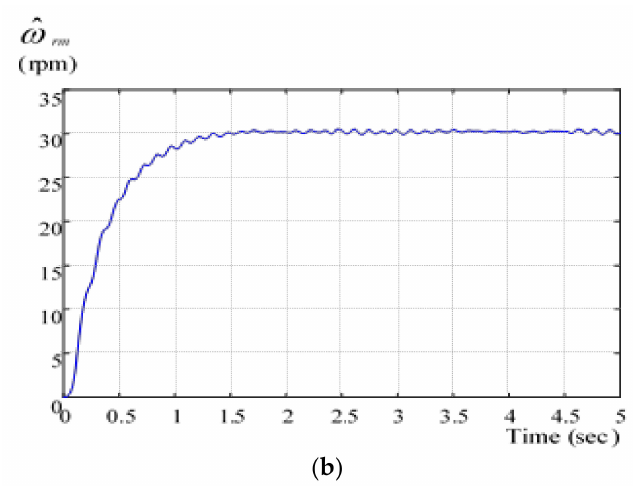
Figure 10. Lowest step-input speed at 30 rpm. ( a ) Simulated; ( b ) measured.